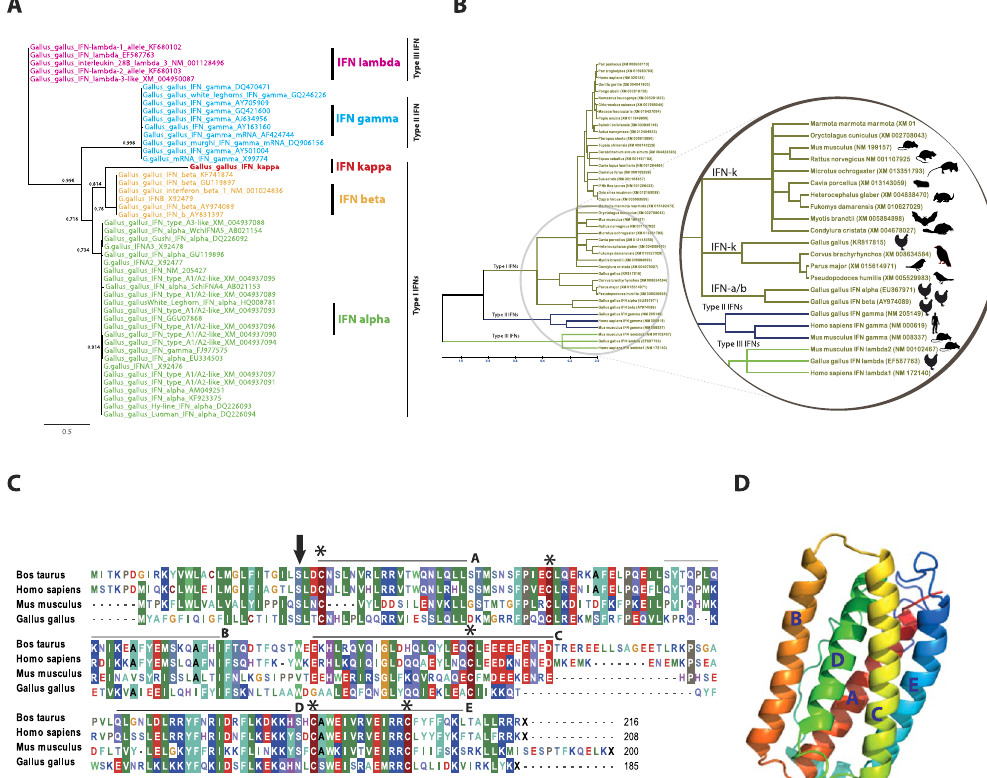
Figure 2. Genetic analysis of IFN genes. ( A) Clustering patterns of all known chicken type I, II and III IFN genes by neighbour-joining method with bootstrap value at n = 2000. The tree was constructed with only ORF sequences including stop codon, and NCBI accession numbers are shown in each of the analysed sequences. Bootstrap values less than 50% were not shown. ( B) Phylogenetic tree of type I, II and III IFNs from different mammals, aves and rodents. The inset highlights the association of chicken IFN- κ with closest avian and non- avian species. NCBI accession numbers used for the analysis are shown in parentheses in each of the sequence in the tree. ( C ) Alignment of the chicken IFN- κ with IFN- κ protein sequences of bovine (NM_001206423), human (NM_020124) and mouse (NM_199157). Amino acid sequences were aligned using ClustalW algorithm and colour represents similarities in the amino acid properties. Putative cleavage signal is marked with down head arrow and five conserved cysteines are labelled with asterisk. Sequences overlaid with lines represent α -helices (A to E) corresponding to human IFN- κ . ( D) Predicted three-dimensional structure of chicken IFN- κ where five α -helices are